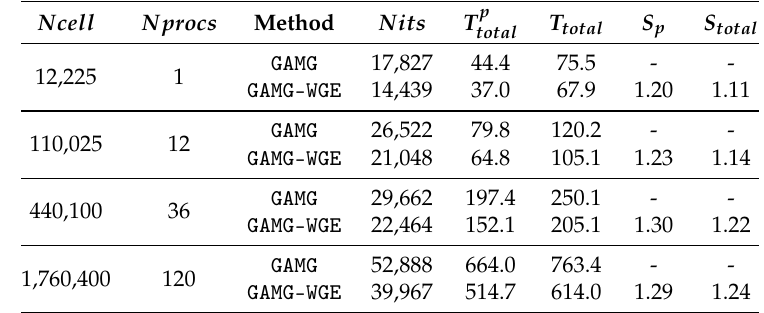
Figure 9. The iteration numbers of the linear equation systems in pitzDaily. Table 2. The test result of